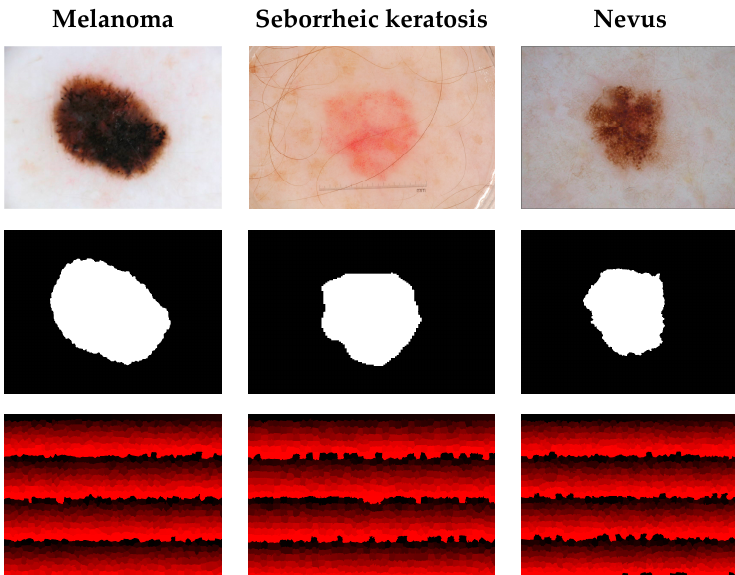
Figure 7. Examples of lesion images from ISIC 2017 and their masks. The first row shows the original images of different lesions. The second row shows the segmentation masks. The third row shows the superpixel mask for dermoscopic feature extraction. The scales for the lesion images are 1022 pixels × 767 pixels, 3008 pixels × 2000 pixels and 1504 pixels × 1129 pixels, respectively.